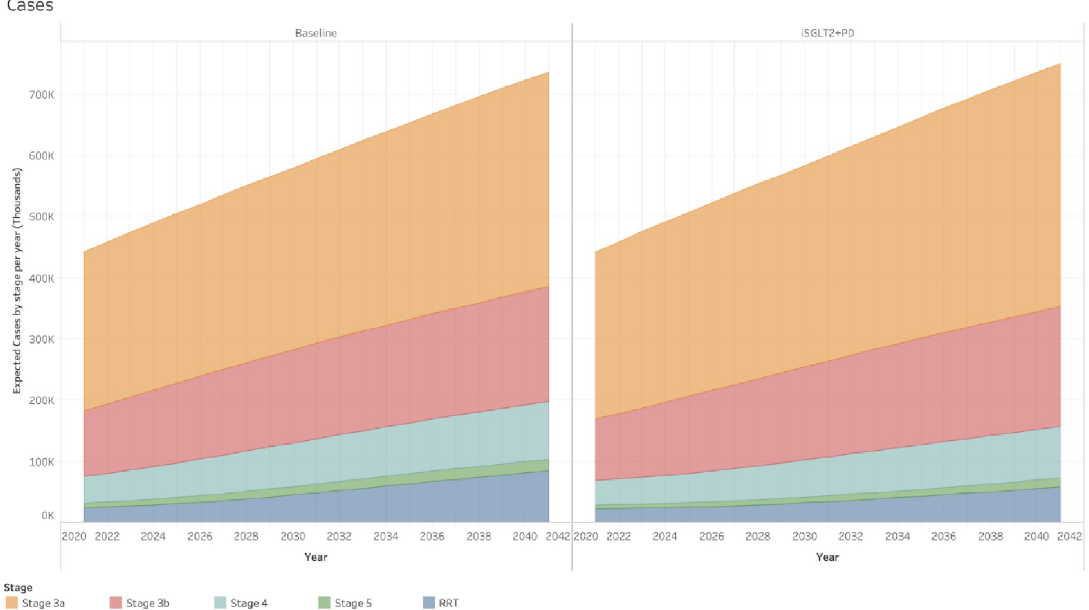
Fig 3. Expected number of cases per year, CKD stage and scenario. Comparison of expected number of cases between the two scenarios included in the study. The difference in the proportion of fast, medium and slow progressors between stages creates a difference in the distribution of individuals between them. In the baseline scenario individuals progress faster, thus the number of individuals in RRT by the end of 2041 is higher. Conversely, in the scenario that includes treatment with SGLT2 inhibitors for individuals with CKD stages 3a and 3b with diabetes mellitus, and pre-dialysis treatment for individuals with CKD stage 4 and 5, there would be a lower number of individuals in RRT by the end of